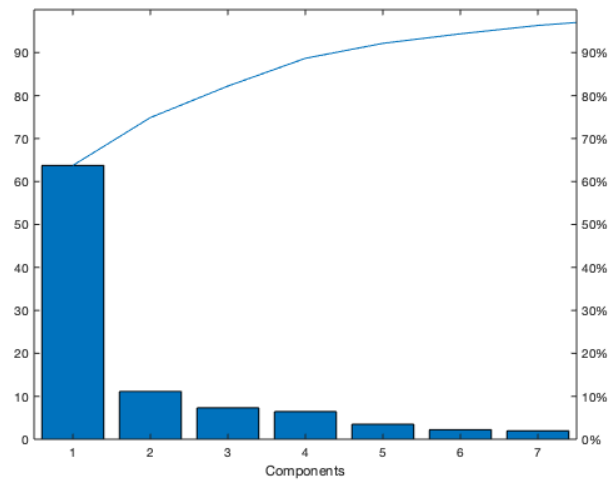
Figure 4. Importance of individual